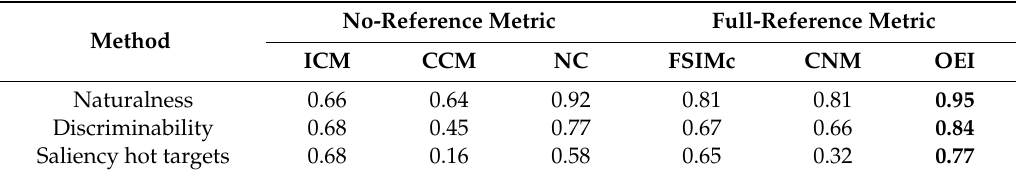
Table 2. Pearson’s correlation coefficient between the computational image quality metrics and the observer ratings for naturalness, discriminability and the saliency of hot targets. Overall highest values are printed in